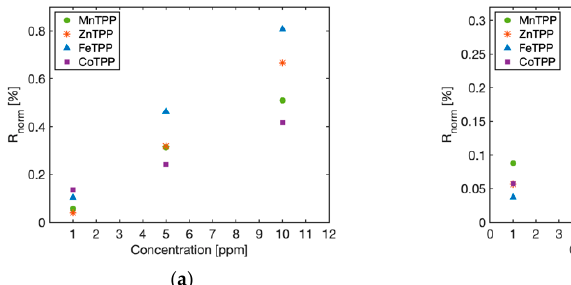
Figure 5. ( a ) Transient responses of RGO–MnTPP, –ZnTPP, –FeTPP, and –CoTPP were plotted when subjected to 5 ppm of ammonia. ( b ) A radar plot shows the sensing responses of the RGO–metalloporphyrin-sensing array for acetone, isopropanol, ammonia, and carbon monoxide.